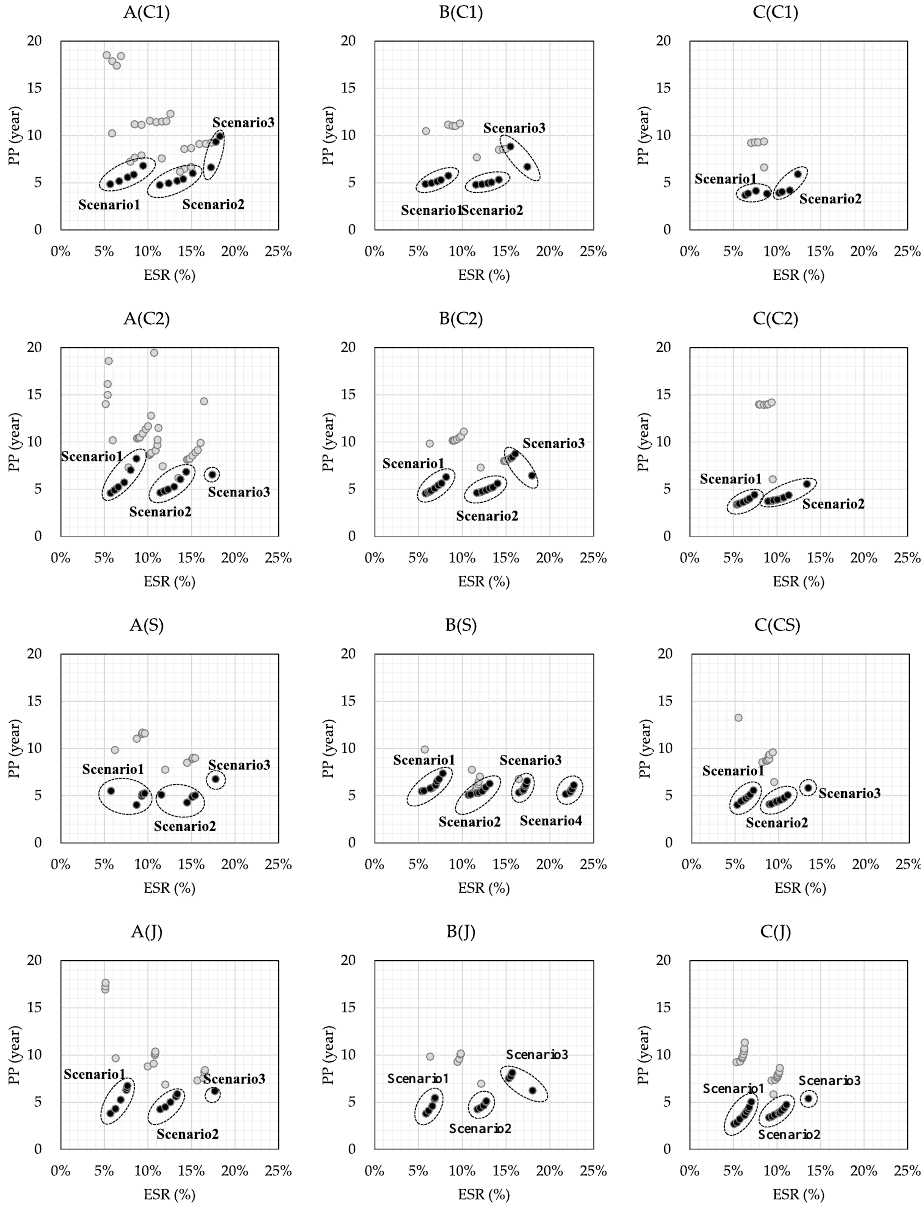
Figure 9. ESR and PP derived by the process of selecting ECM combinations.